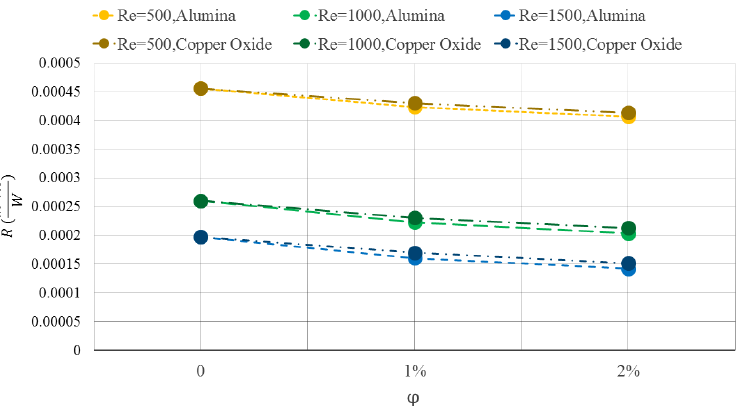
Figure 7. WMCHS thermal resistance for Water/Al 2 O 3 and Water/CuO NFs at three different Res of 500, 1000, and 1500.